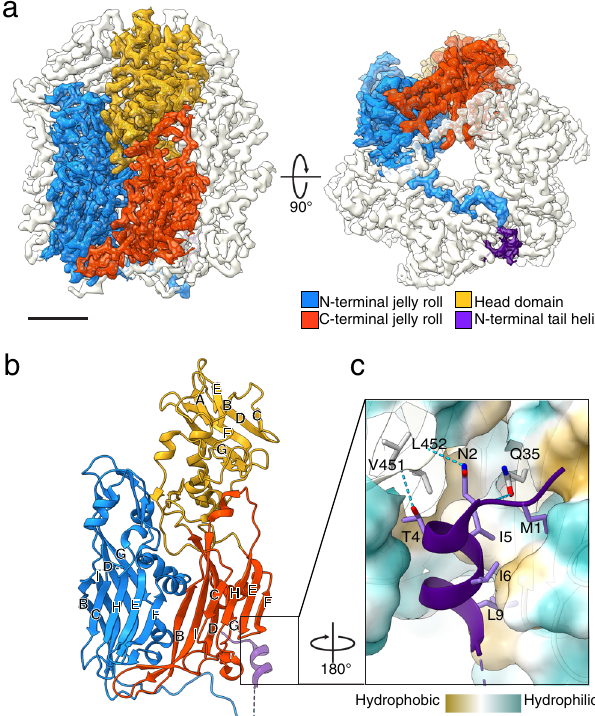
Fig. 1 Cryo-EM structures of the VACV D13 trimer. a Isoelectron potential surface of the cryo-EM reconstruction of the D13 trimer contoured at 3.0 σ above average. The map resolution is 2.3 Å. The fi tted atomic model of one monomer is shown in stick representation within the transparent isosurface. b Schematic architecture of the D13 monomer depicted in ribbon representation, composed of two jellyroll domains and one head domain. β -strands in each domain are labeled in alphabetical order, based on ascending amino acid sequence. c A close-up view of the N-terminal tail α -helix model stabilized in the hydrophobic pocket of a neighboring monomer and hydrogen bonds (dashed cyan line). The Conolly surface of that monomer is colored according to its molecular lipophilicity